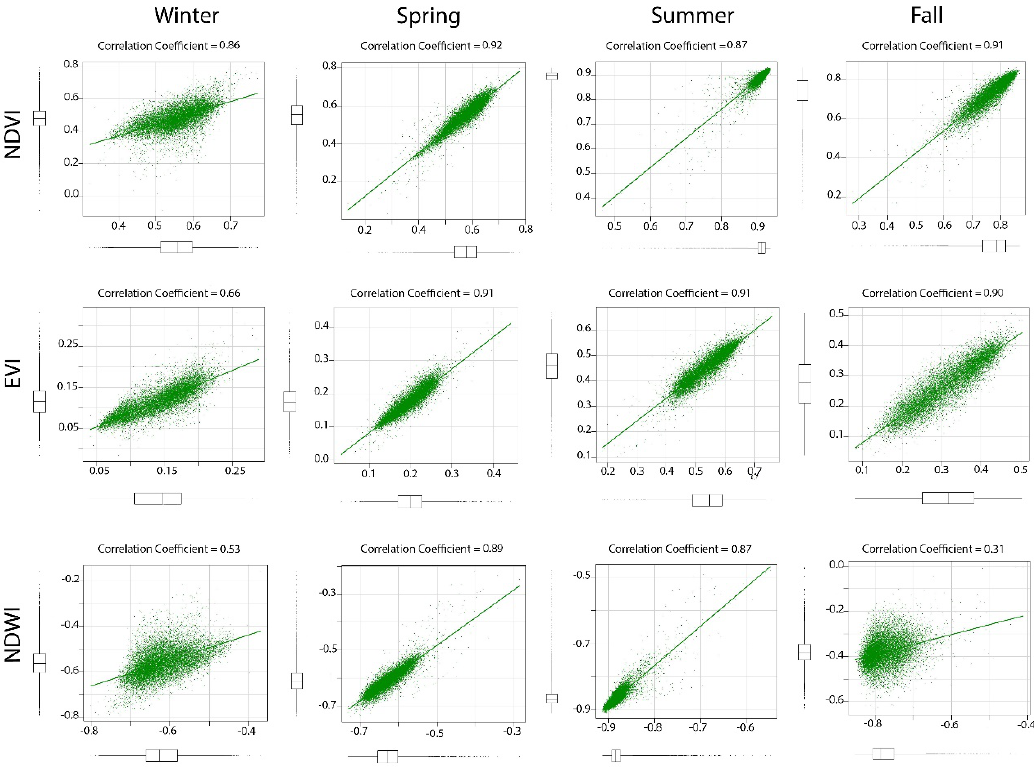
Figure 4. Scatterplots of each index per season (x-axis depicts Landsat while y-axis depicts Sentinel data) .